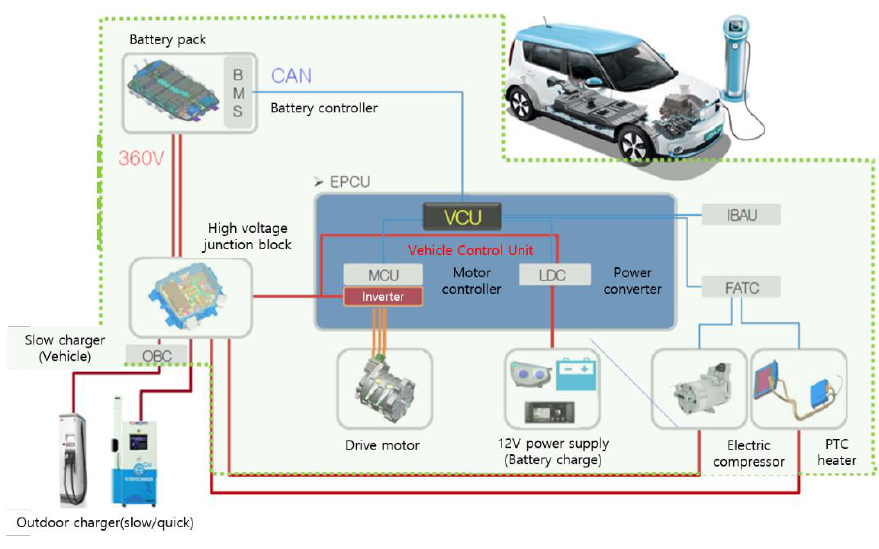
Figure 1. Block diagram of the electric vehicle.